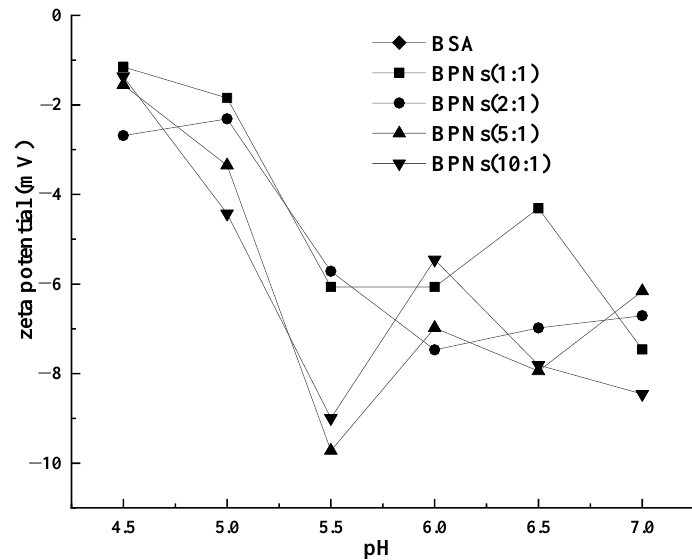
Figure 2. Zeta potential of BPNs as a function of pH.